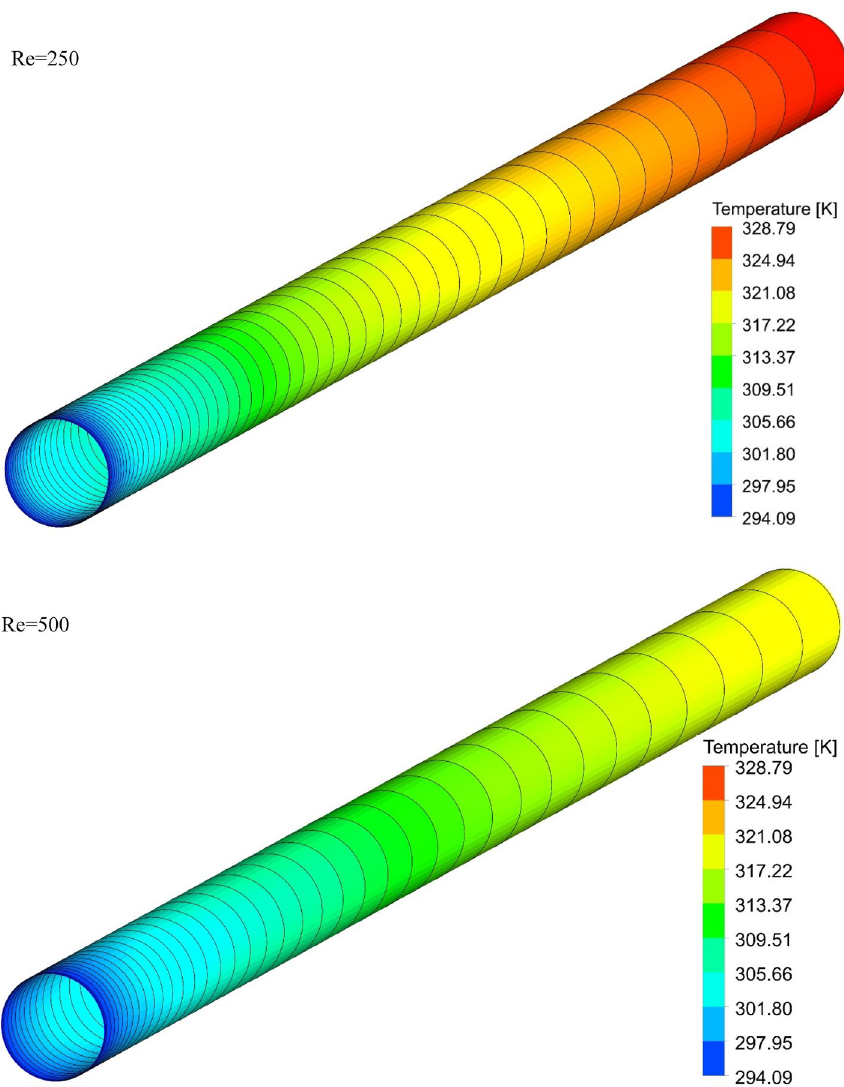
Figure 13. Isotherm contours on the surface of the pipe in φ = 0% and Case